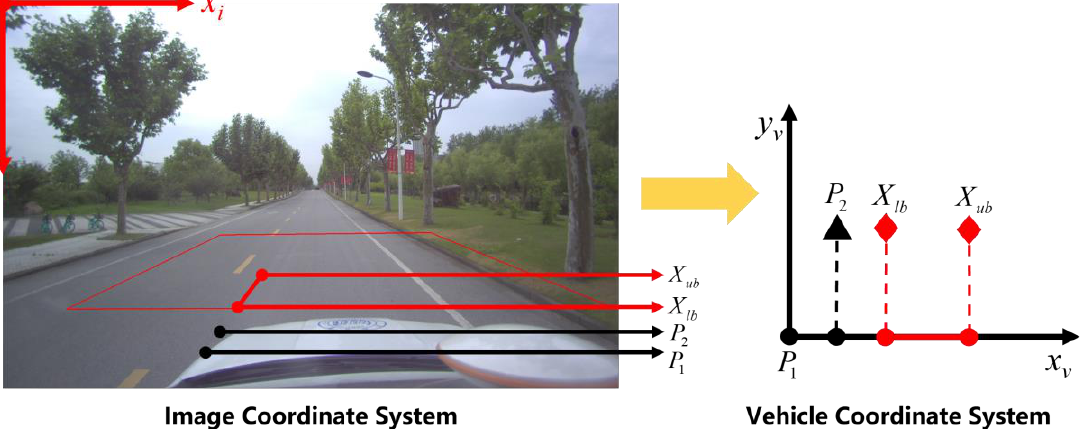
Figure 10. The spatial position relationship in the spatiotemporal transformation strategy.